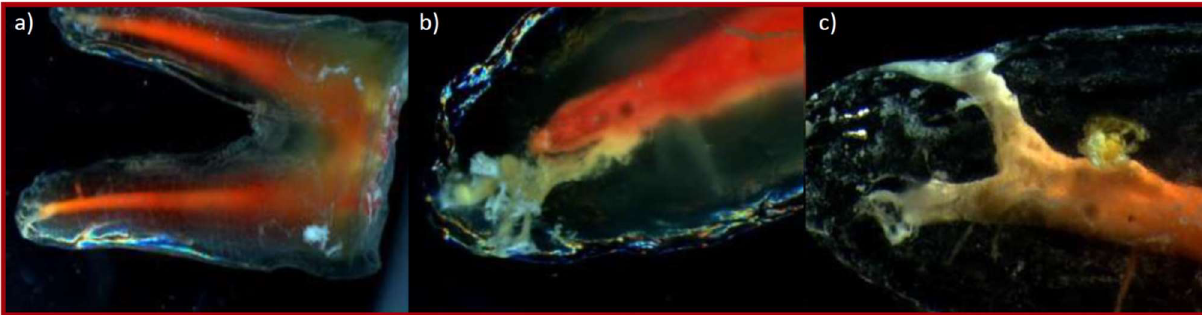
Figure 14. Results of observations in a light microscope of teeth after filling the root canal with thermoplastic gutta-percha studs prepared with the decalcification technique: ( a ) view of a two-root tooth with a root delta in each root and a lateral branch of the root canal in the lower part of the image (8×); ( b ) view of the root of the tooth with the delta-filled complex structure of the root canal filled with sealant (50×); ( c ) root canal delta filled with sealant (50×).